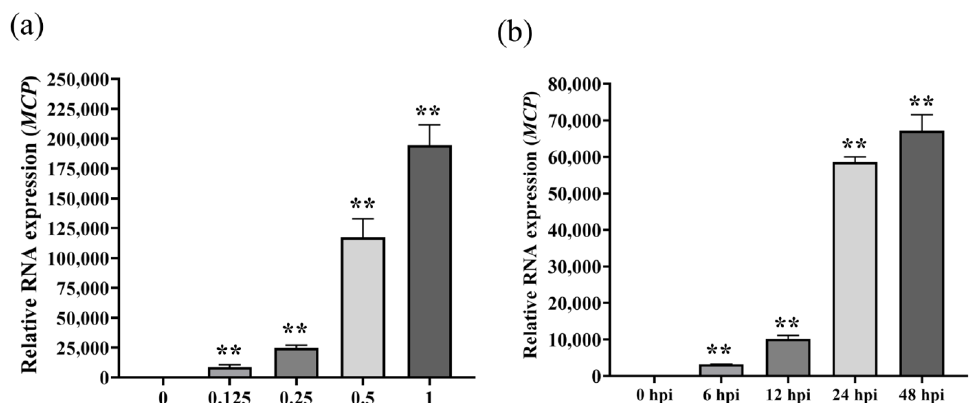
Figure 3. Monitoring SGIV infection by RT-qPCR. ( a ) RT-qPCR detected SGIV (MOI = 0.125) infection as early as 6 hpi. ( b ) RT-qPCR detect SGIV (MOI = 0.5) infection at 48 hpi. Results are presented as mean ± SD of three independent experiments (** p < 0.01).